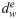
Comparison of reconstructed results estimated with 15 gradient directions and 3 orthogonal gradient directions in the first imaging slice of the brain.(a) extracellular volume fraction α, (b) extracellular mean diffusivity dwe, (c) intracellular diffusivity dwi, and (d) low-frequency mean conductivity σL. The 3-rd and 6-th columns show the absolute values of difference between the corresponding results with 15 and 3 gradient directions, respectively.